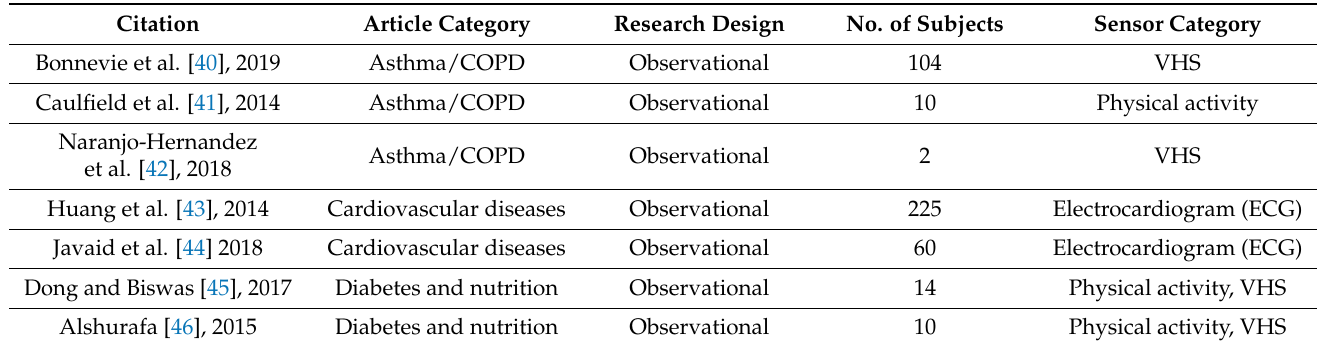
Table 2. Summary of related experimental research works on IoHT and Vital Health Signs.